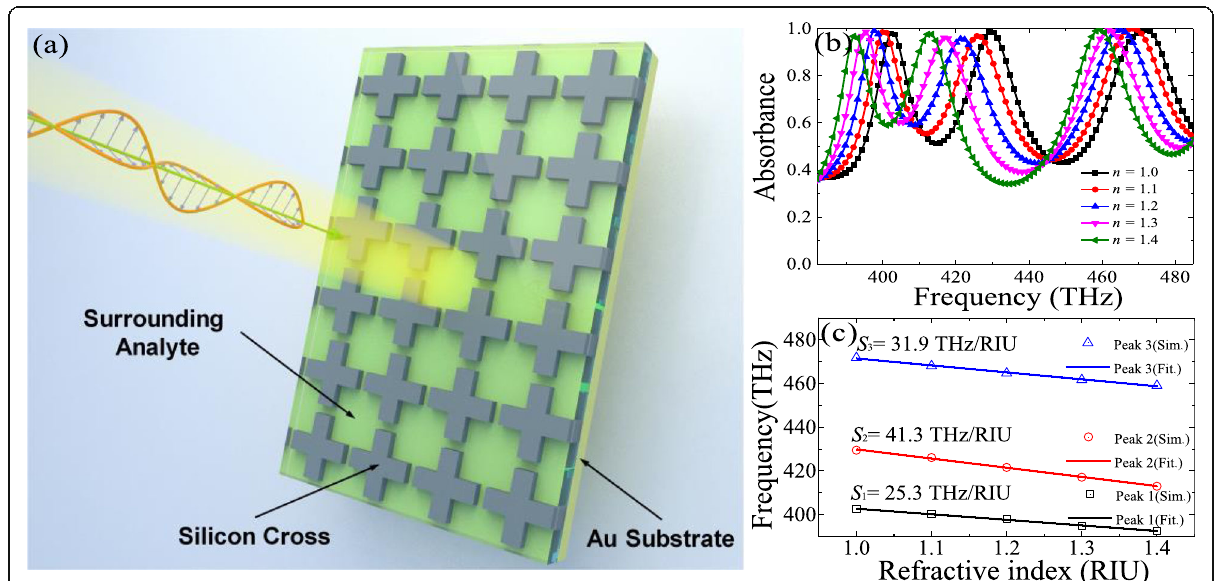
Fig. 6 a The schematic of the PLA for RI sensing application. b the simulated absorbance spectra of the PLA by varying the RI values of surrounding analyte from n = 1.0 to n = 1.4 by step of 0.1. c Linear fit (solid lines) and simulated resonance frequencies (hollow symbols) as a function of RI values of the surrounding